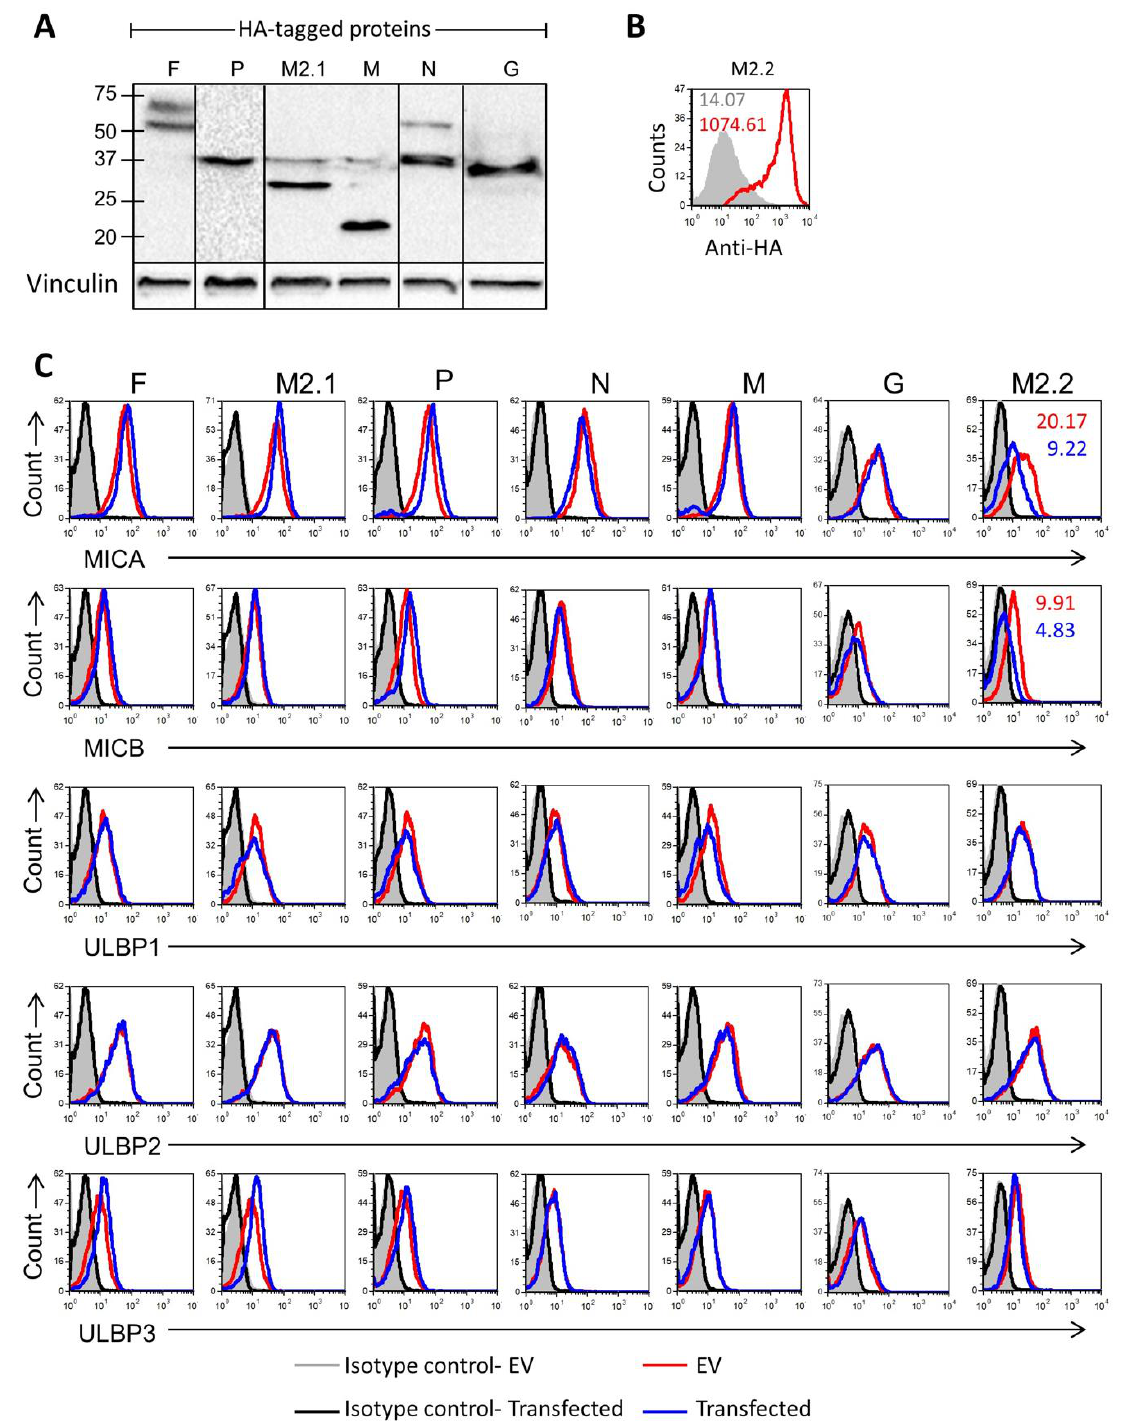
Figure 5. NKG2D ligands expression following expression of HMPV proteins. ( A ) Western blot analysis of the HMPV HA-tagged proteins F, P, M2.1, M, N, and G in transfected A549 cells (upper panels). Vinculin expression was used as a loading control (lower panels). Contrasts in the WB were altered for better clarity. ( B ) Fluorescence-activated cell sorting (FACS) analysis of intracellular staining with the anti-HA antibody of the HA-tagged protein M2.2 in transfected A549 cells. The red empty histogram represents HA staining, and a gray-filled histogram represents staining with a control antibody. Intracellular expression levels were also shown as MFI. The figure is representative of three independent experiments. ( C ) FACS analysis of the MHC) class I polypeptide-related sequences A and B (MICA), (MICB), UL16 binding proteins (ULBP1), (ULBP2), and (ULBP3) expression in A549 cells transfected with the indicated proteins. The blue empty histogram represents